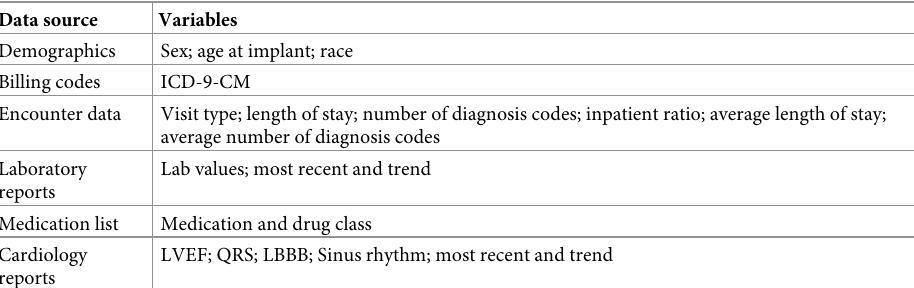
Table 1. Structured data vectors utilized in machine learning